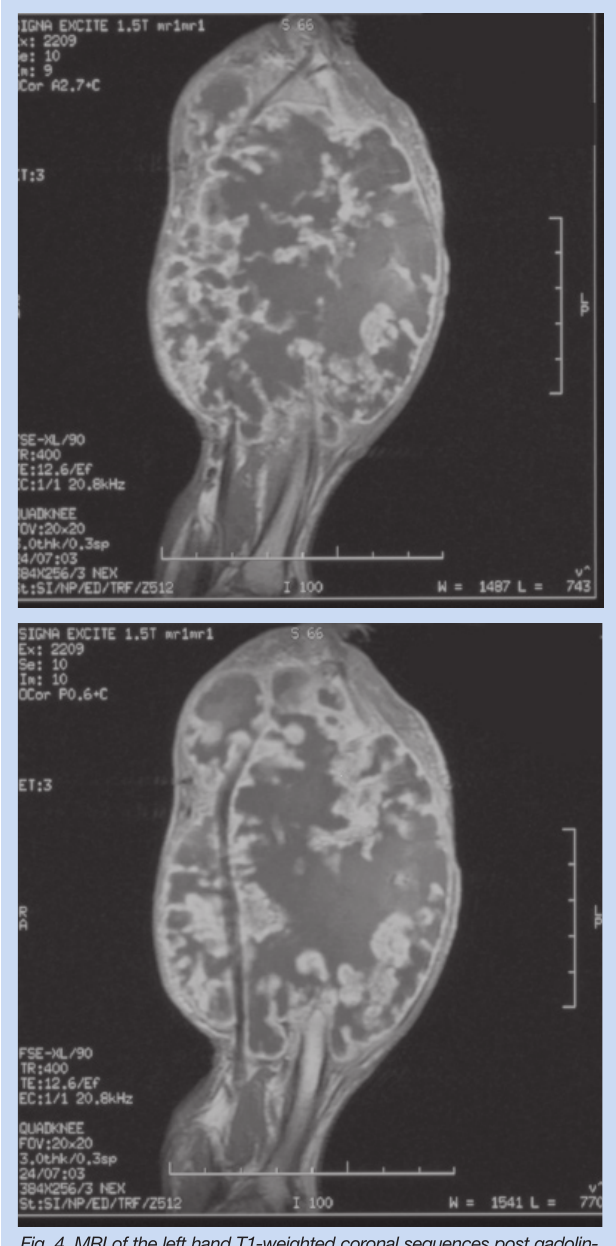
Fig. 4. MRI of the left hand T1-weighted coronal sequences post gadolin- ium enhancement, showing intense peripheral and septal enhancement of the lesion, with involvement of the ligaments of the index